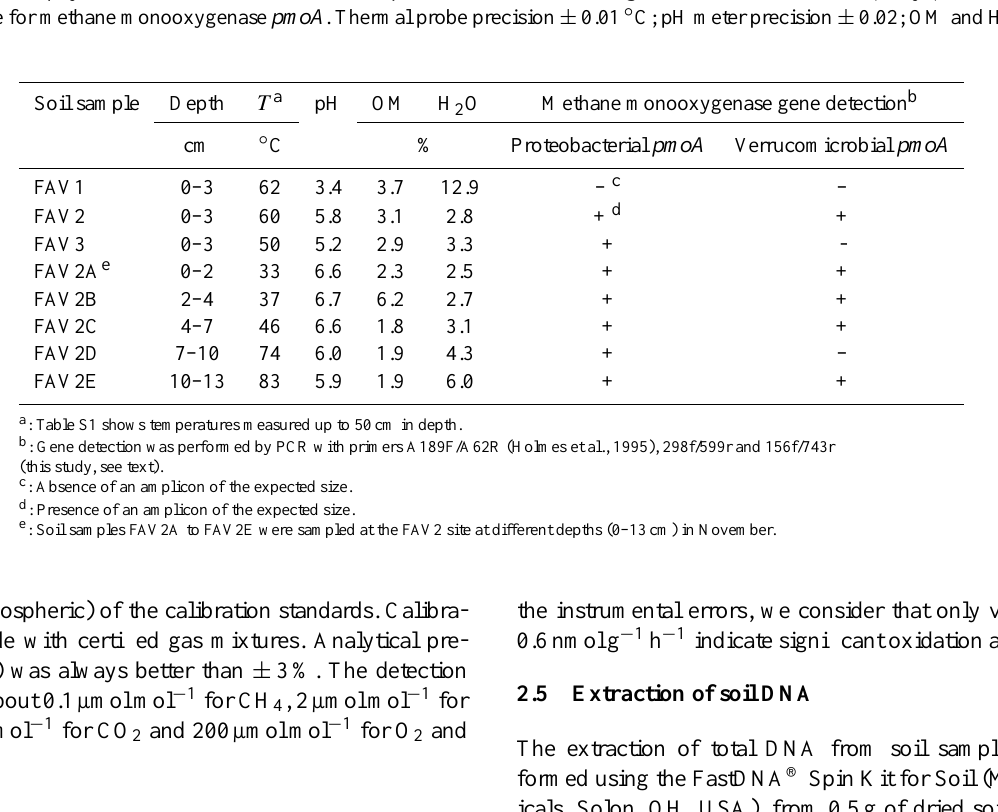
Table 1. Chemical–physical characteristics of the soil sampled at the Favara Grande geothermal site (Pantelleria, Italy), and detection of the functional gene for methane monooxygenase pmoA . Thermal probe precision ± 0.01 ◦ C; pH meter precision ± 0.02; OM and H 2 O precision ± 0.01%.